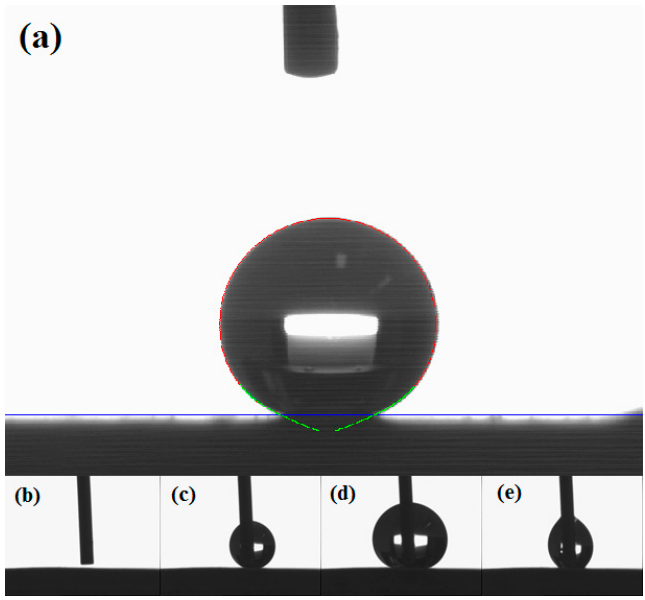
Figure 14. ( a ) a demonstration of the Tangent approximation method and ( b – e ) the procedure for determination of advancing and receding angles. determination of advancing and receding